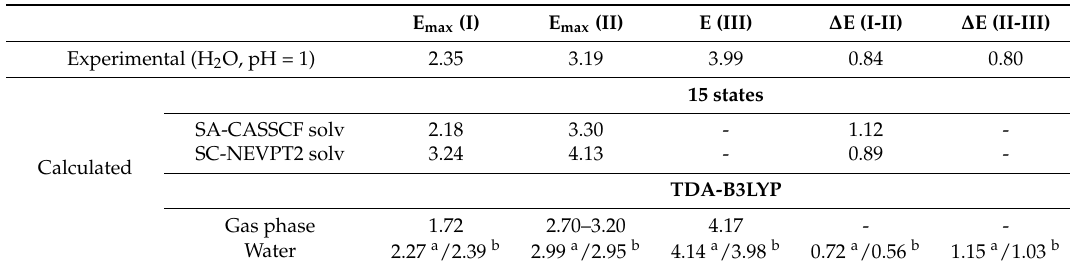
Table 3. Calculated and experimental (H 2 O, pH = 1) absorption maxima (E max ) of the three UV-VIS absorption bands (I, II, and III) and the corresponding band separation ( ∆ E) for N3. All energies are in eV. Data are from